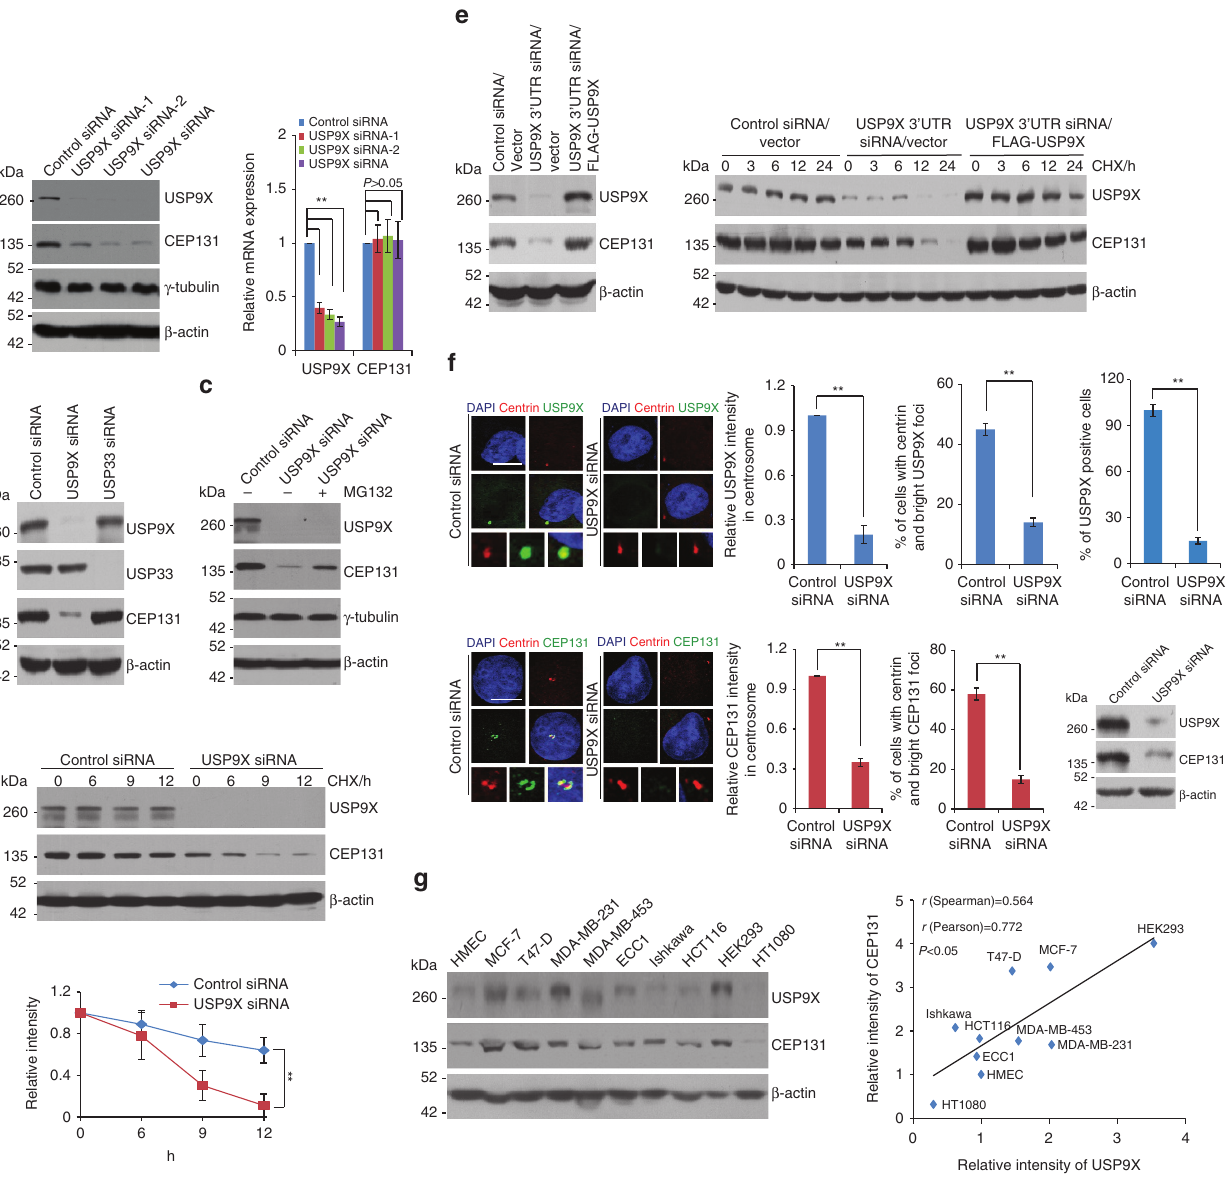
Figure 3 | USP9X promotes CEP131 stabilization. ( a ) MCF-7 cells were transfected with control siRNA or different sets of USP9X siRNAs. Cellular extracts and total RNA were prepared and analysed by western blotting and qRT (quantitative reverse transcription)–PCR, respectively. Each bar represents the mean ± s.d. for biological triplicate experiments. ** P o 0.01, one-way analysis of variance (ANOVA). ( b ) MCF-7 cells were transfected with control siRNA, USP9X siRNA or USP33 siRNA followed by western blotting analysis. ( c ) MCF-7 cells were transfected with control siRNA or USP9X siRNA followed by treatment with dimethylsulphoxide or proteasome inhibitor MG132 (10 m M). Cellular extracts were prepared and analysed by western blotting. ( d ) MCF-7 cells transfected with control siRNA or USP9X siRNA were treated with CHX and harvested at the indicated time followed by western blotting analysis. Intensity of each band from biological triplicate experiments was quantified by densitometry with the Image J software with b -actin as a normalizer. Each bar represents the mean ± s.d. for biological triplicate experiments. ** P o 0.01, two-way ANOVA. ( e ) Control U2OS cells or U2OS cells stably expressing USP9X were transfected with control siRNA or USP9X 3 0 UTR siRNA for 96h followed by western blotting analysis (left panel). Control U2OS cells or U2OS cells stably expressing USP9X were transfected with control siRNA or USP9X 3 0 UTR siRNA for 96h, then treated with CHX and harvested at the indicated time followed by western blotting analysis (right panel). ( f ) U2OS cells transfected with control siRNA or USP9X siRNA were fixed and subjected to immunostaining (left panel). Scale bars, 10 m m. Percentage of cells with double staining or USP9X knockdown was counted, and the relative intensity of USP9X or CEP131 in centrosome was analysed by the Image J software (right panel). Each bar represents the mean ± s.d. for biological triplicate experiments. ** P o 0.01, two-tailed unpaired t -test. The knockdown effect of USP9X was examined by western blotting. ( g ) Western blotting analysis of the expression of USP9X and CEP131 in multiple cell lines. Intensity of each band was quantified by densitometry with the Image J software with b -actin as a normalizer. The correlation coefficient and P values are